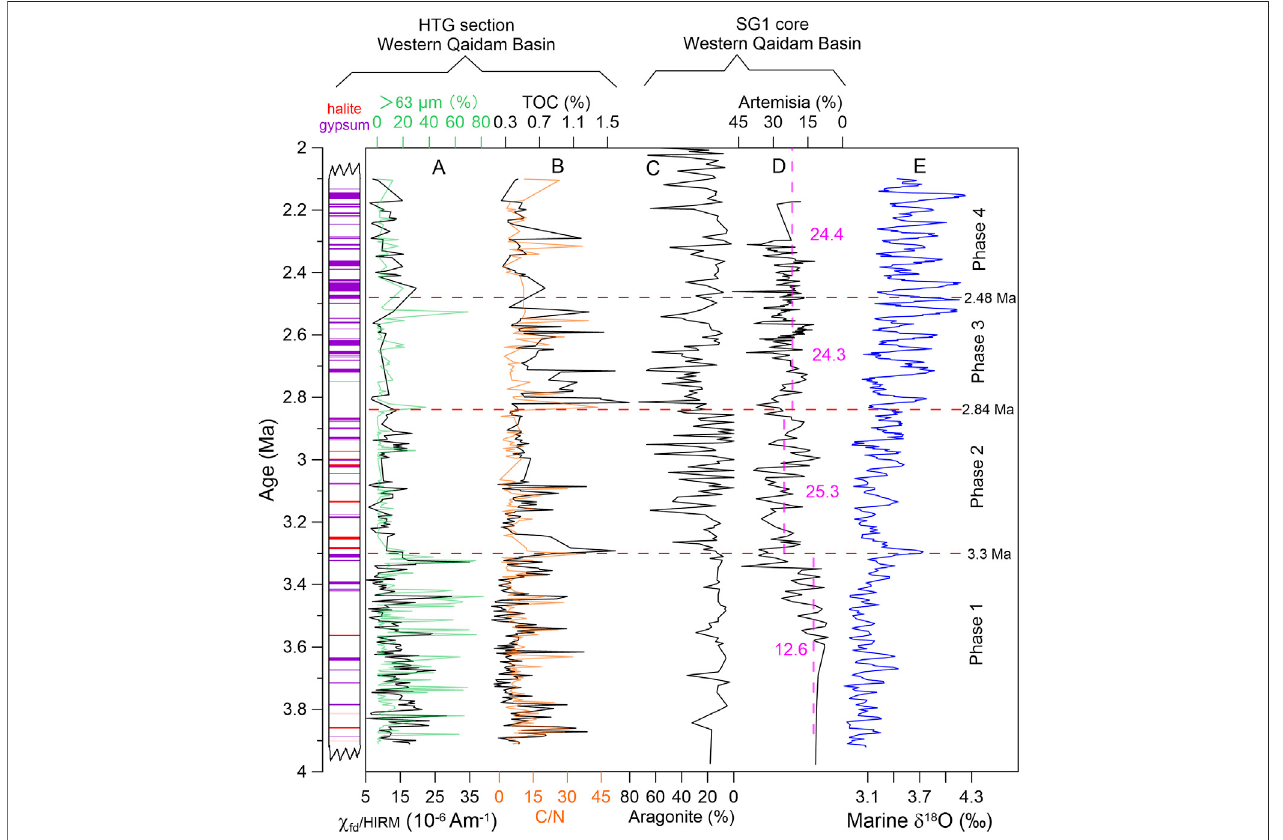
FIGURE 4 | Late Pliocene paleoenvironmental records from the Huatugou section and the SG1 core in the western Qaidam Basin. (A) The > 63 μ m fraction grain size record (green line) and the χ fd /HIRM record (black line, Su et al., 2019b) of the Huatugou section in the western Qaidam Basin. (B) The TOC record (black line) and C/N ratio record (yellow line) of the Huatugou section in the western Qaidam Basin. (C – D) The aragonite record (Fang et al., 2016) and the artemisia record (Koutsodendrisetal.,2019)fromtheSG1coreinthewesternQaidamBasin. (E) Marine δ 18 Orecord(Zachosetal.,2001).Threephase boundariesat ∼ 3.3, ∼ 2.84, and ∼ 2.48 Ma are labeled with red dashed